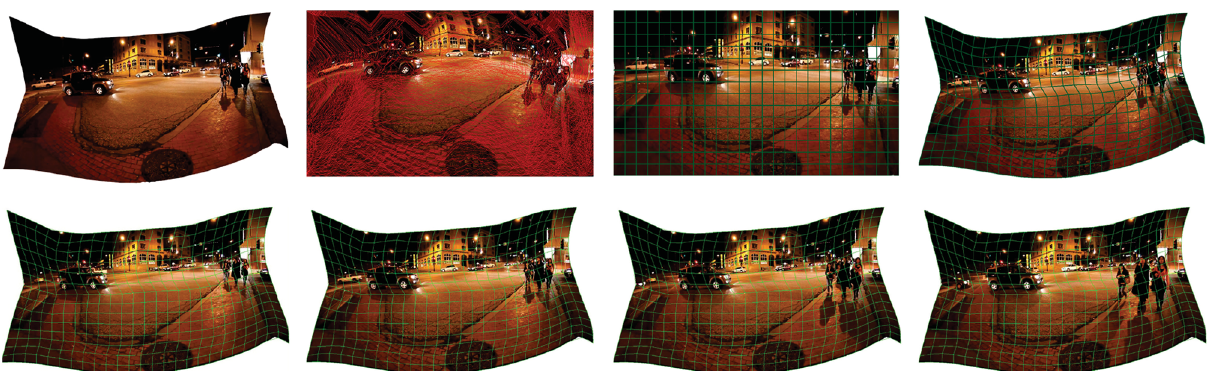
Fig. 2 Above: per-frame quad mesh placement by the method of Ref. [15]. Red lines: inserted seams. Green lines: mesh edges. Below: the consistent quad mesh grid through four successive frames (7th–10th frames).